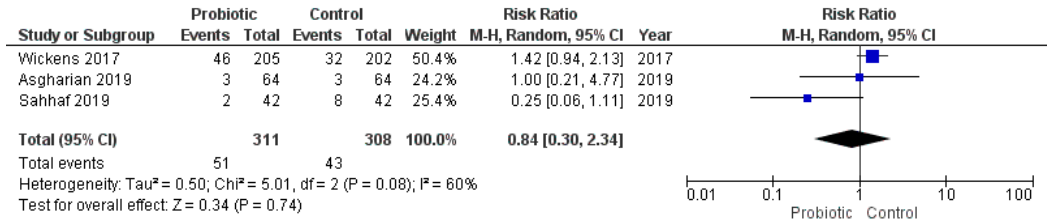
Figure 9. Meta-analysis of studies evaluating the administration of probiotic and large for gestational age.